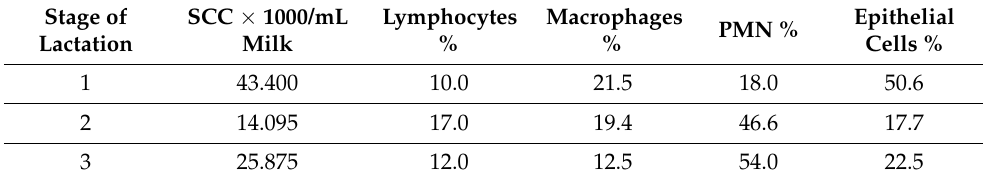
Table 5. Mean values of SCC and differential fraction of SCC during three stages of lactation [9]. Stage